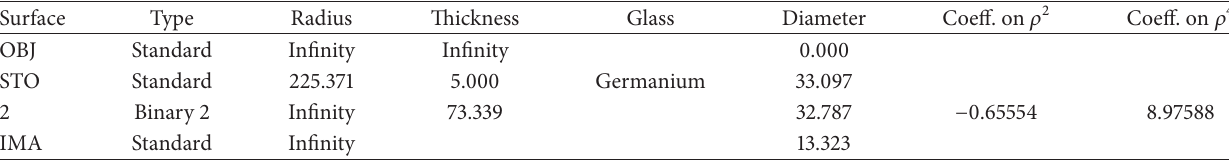
Table 2: Specifications of the diffractive lens (mm).